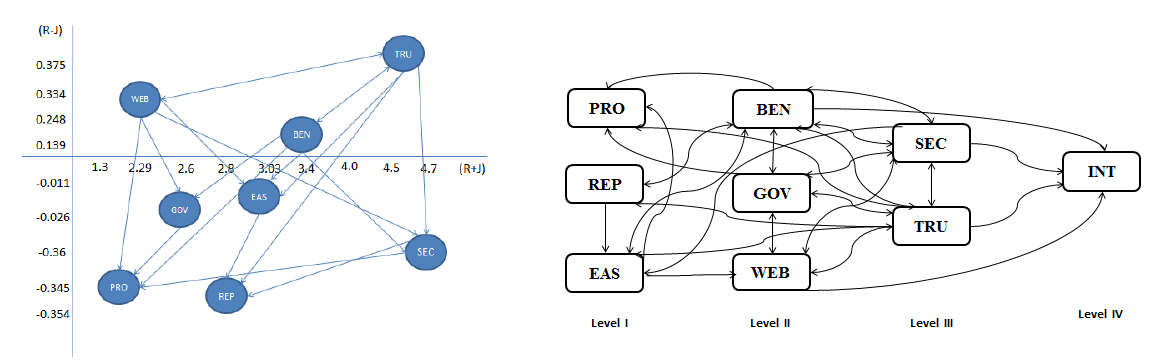
Fig. 2. The results of direct and indirect